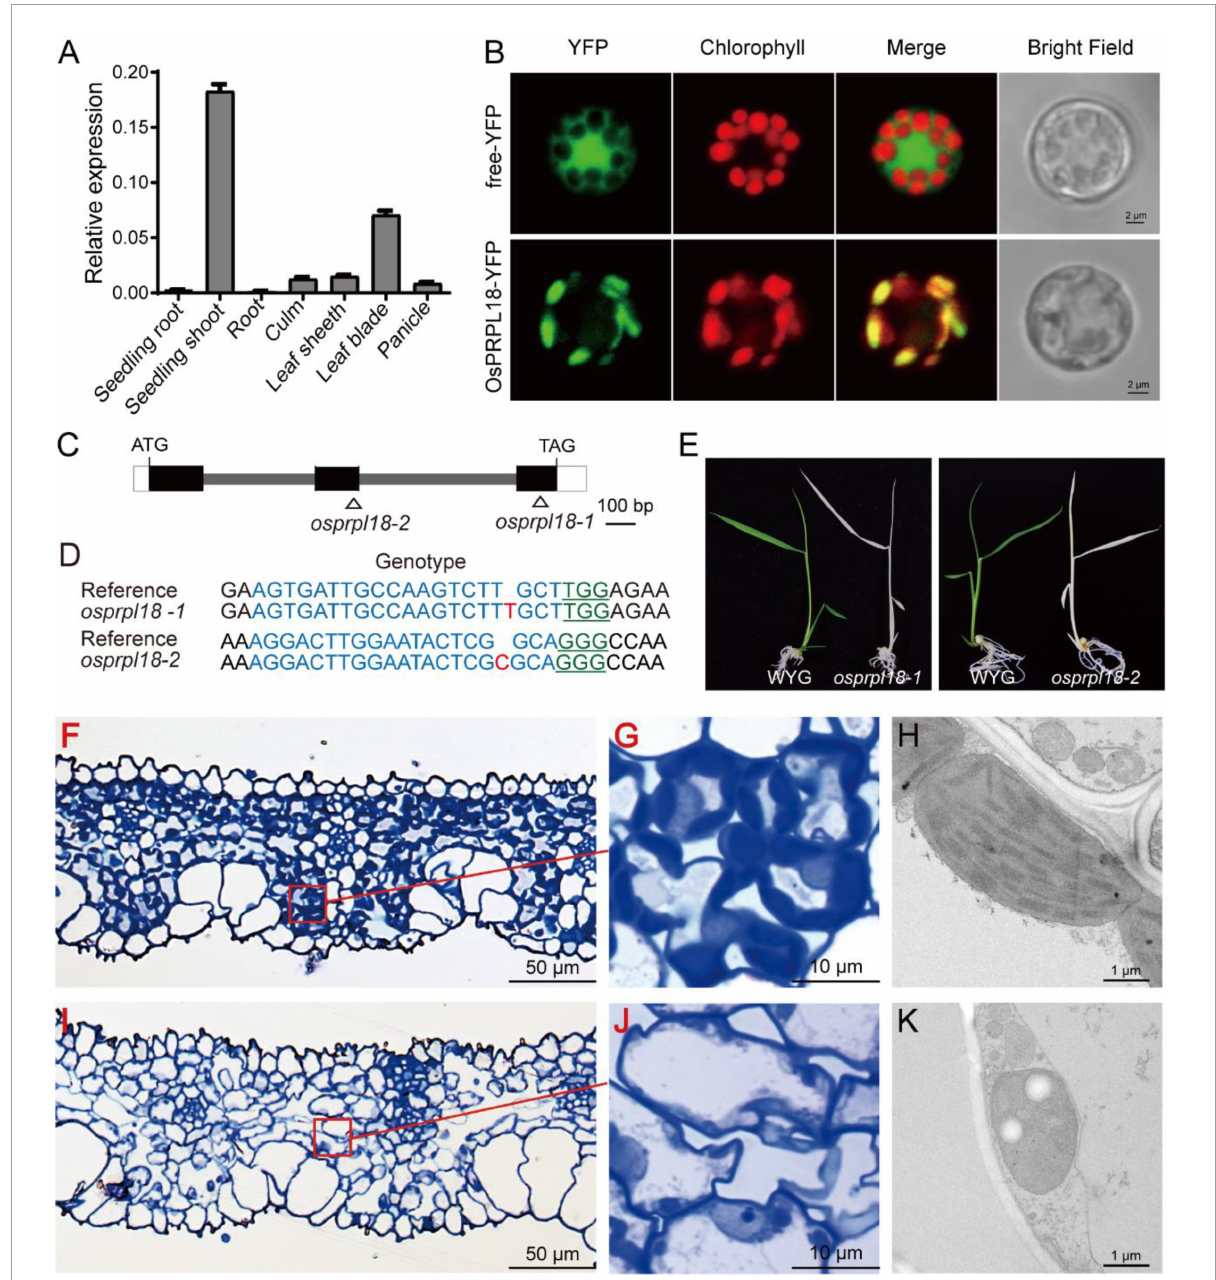
FIGURE5 Characterization of the function of OsPRPL18 in rice. (A) The gene expression of OsPRPL18 in various rice tissues. UBQ served as the internal control. Data represent means ± SD from three biological replicates. (B) Subcellular location of OsPRPL18-YFP in rice protoplast. Free YFP was used as a control. The chlorophyll autofluorescence indicates chloroplast. Scale bars = 5 µ m (C) The gene structure of OsPRPL18. (D) The genotypes of osprpl18 mutants. The guide RNA targeted DNA sequence and PAM motif were highlighted in blue and green, respectively. The targeted site was marked as triangle in (C) . (E) 11-day-old seedlings of wild-type rice (WYG) and osprpl18-1 and osprpl18-2 mutants. (F–K) The structure of leaf blade and chloroplast of WYG (F–G) and the osprpl18-1 mutant (I–K)